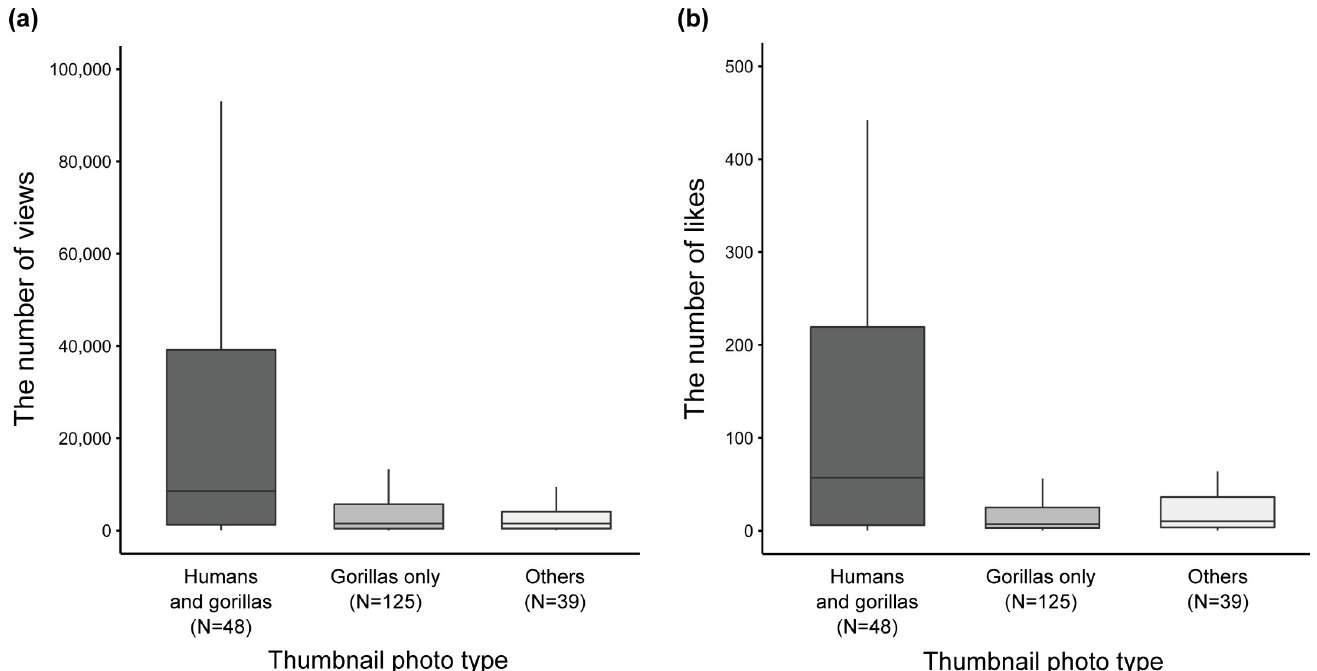
Fig 3. A comparison of the number of views and likes of the sampled YouTube videos related to mountain gorilla tourism (N = 206) between three different thumbnail photo types (a, b). The upper and lower hinges of boxes represent the first and third quartiles and the thick lines in boxes show the medians. The upper whiskers extend out from boxes to the largest value no further than 1.5 � IQR from the hinges while the lower whiskers extend from the boxes to the smallest value no further than 1.5 � IQR of the hinges. As for the y-axis of each figure, only the parts under 100,000 (a) and 500 (b). AR means close proximity within arm’s